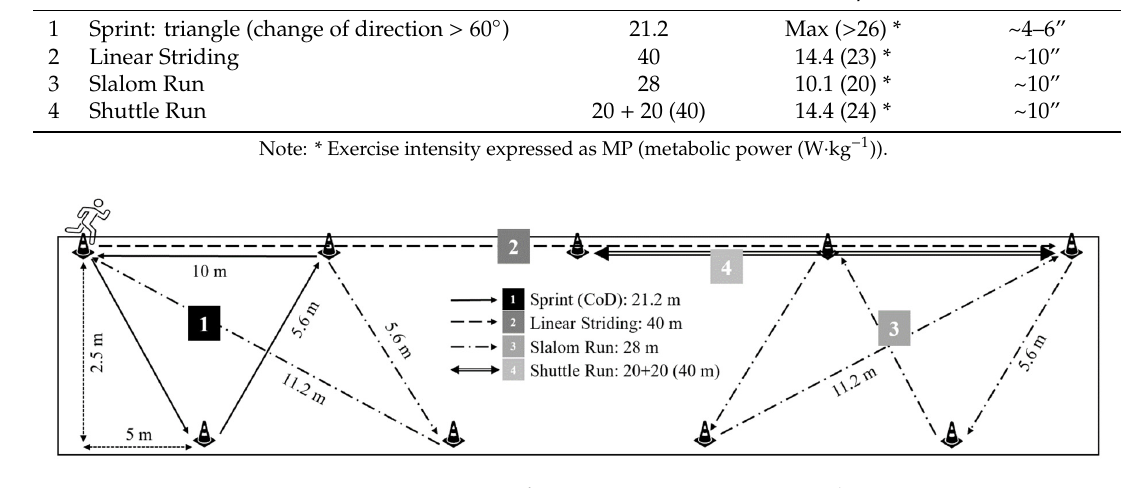
Figure 3. Soccer-specific intermittent exercise protocol.